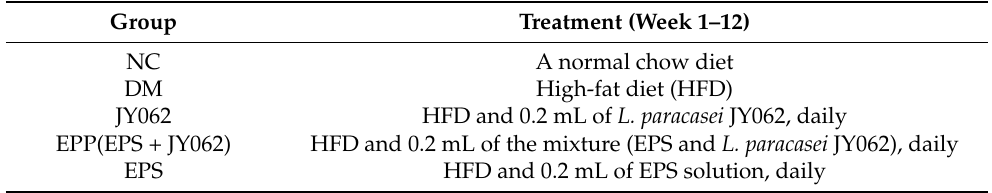
Table 1. Details of dietary treatment of